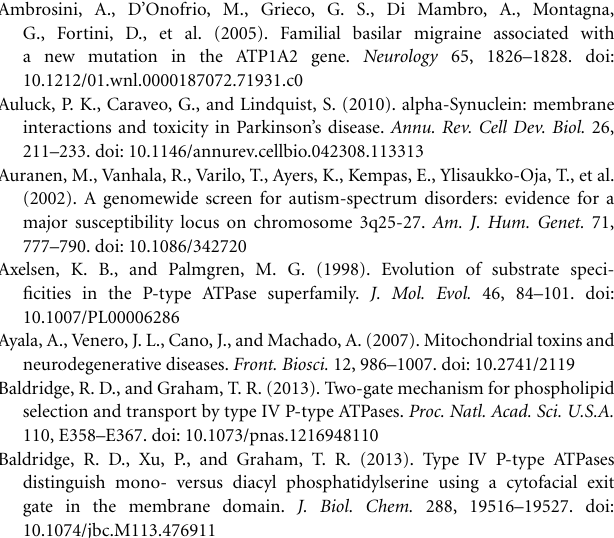
Supplemental Table 1 | Genetic interactions of YPK9 in S. cerevisiae obtained from the yeast genome database (http://yeastgenome.org). The data were were classified using BioGrid (http://thebiogrid.org) according to organellar distribution and function. A summary is provided in Figure 5